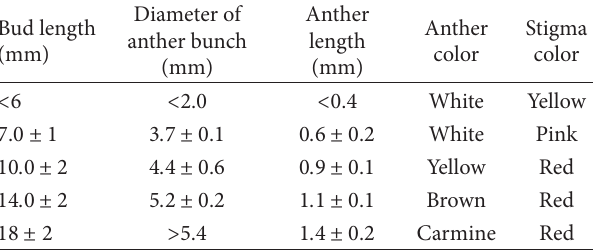
Table 1: Relation between flower bud length, anther size, and stigma color.